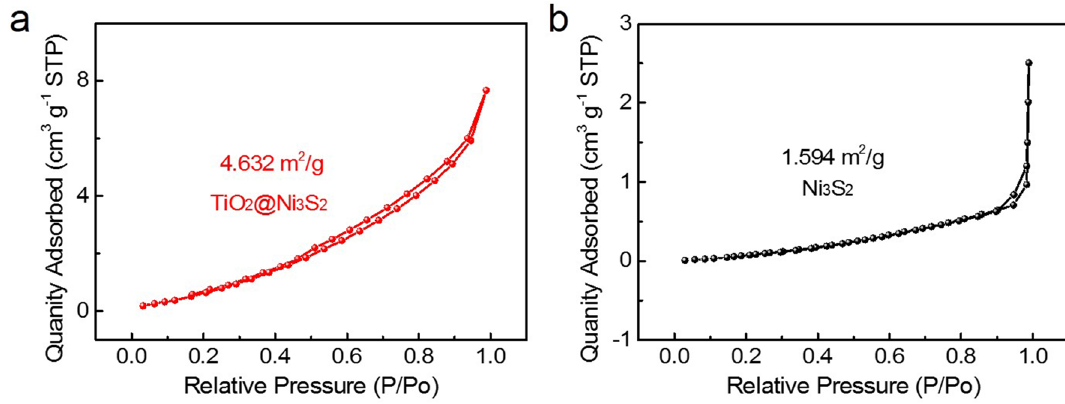
Fig. S4 BET measurements: nitrogen adsorption-desorption isotherm curves: a TiO 2 @Ni 3 S 2 nanowire arrays and b Ni 3 S 2 arrays